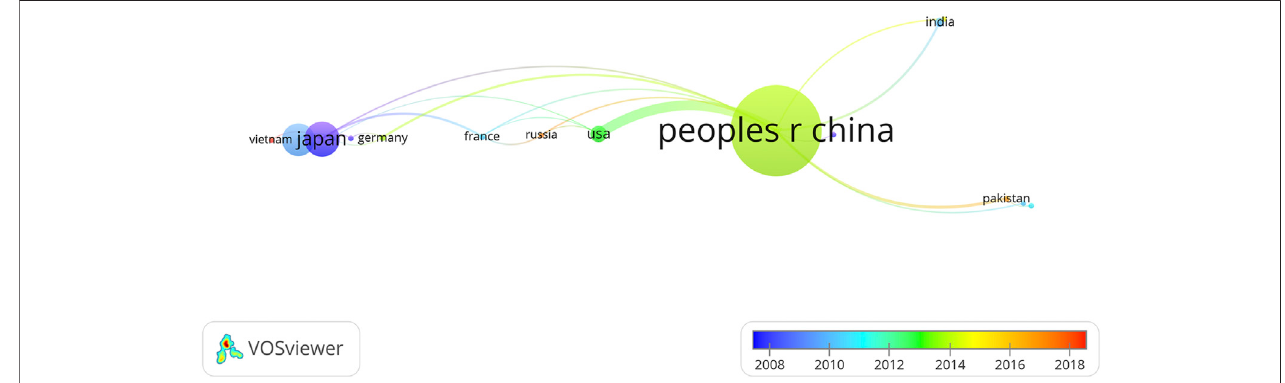
FIGURE 3 | Collaboration network of countries/regions in Coptis research.